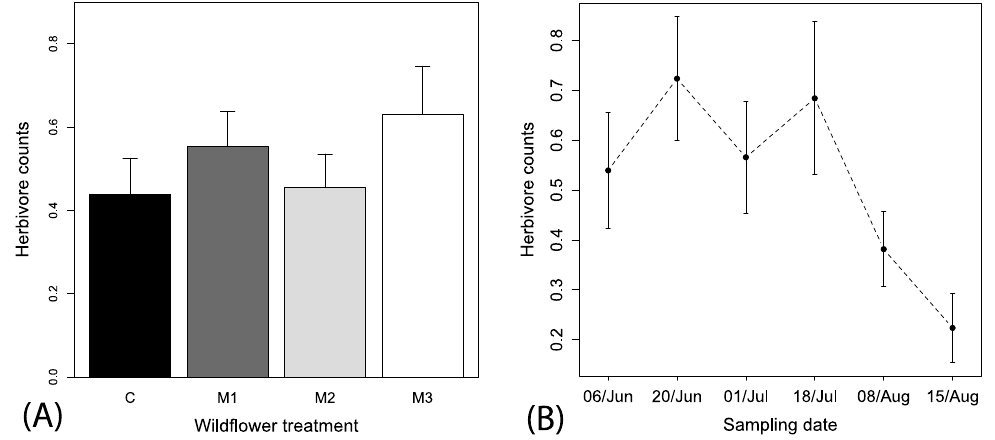
Figure 5. Mean (+1 SE) observations of ( A ) herbivores among the mixes and local spatial context and irrigation treatments and ( B ) mean ( ± 1 SE) herbivores across the sampling periods among the different wildflower treatments. Local spatial context and irrigation descriptions are the same as in Figure 2.